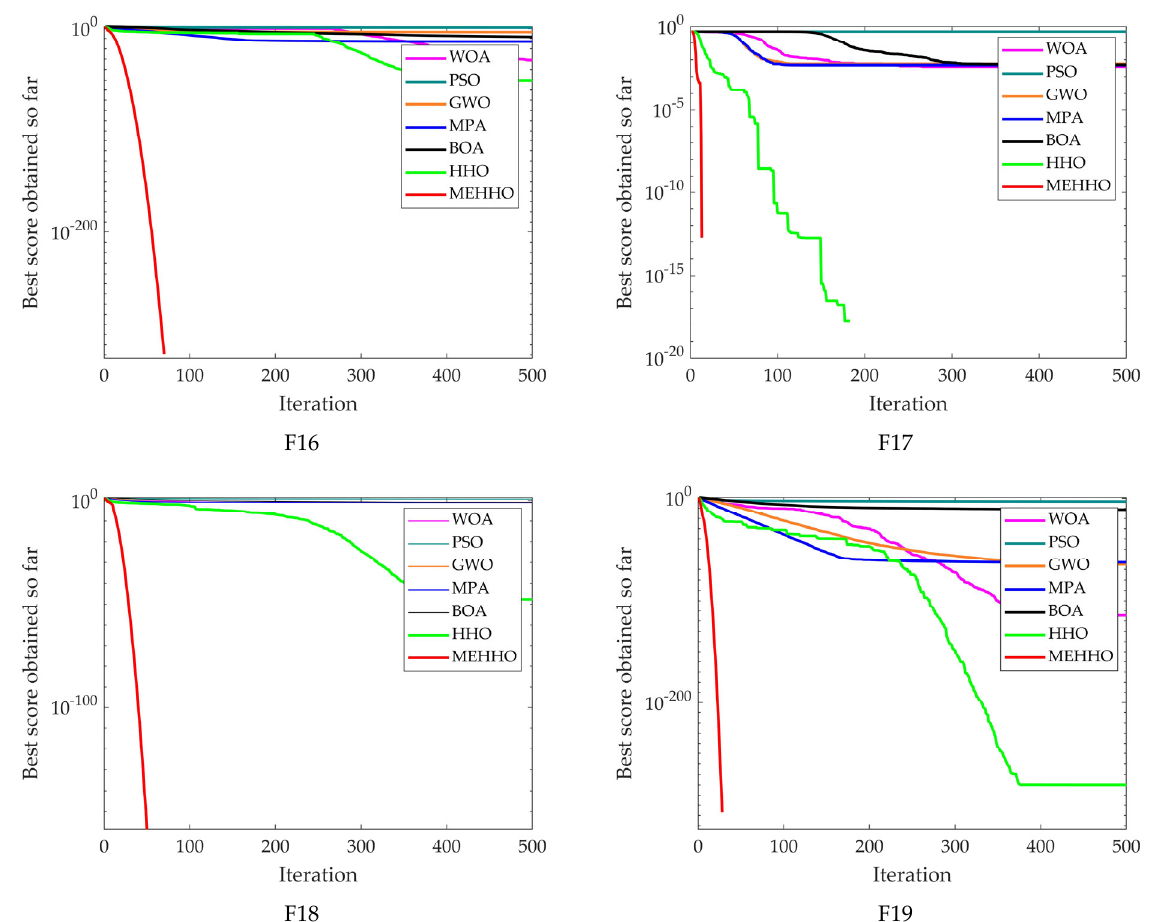
Figure 4. Convergence curve of partial multimodal functions (F12–F19).